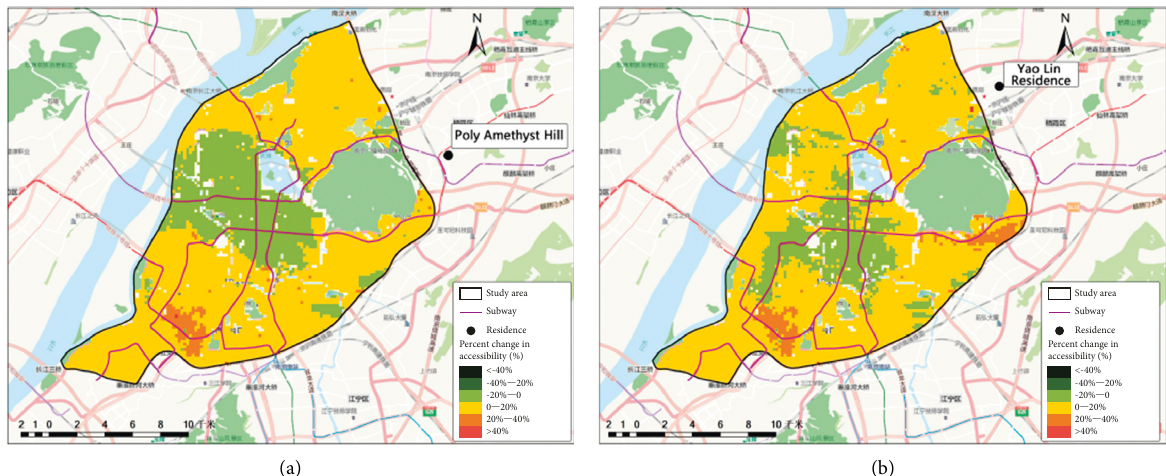
Figure 6: Rangeability in accessibility to Xianlin under the impact of snowstorms. (a) Xianlin, Poly Amethyst Hill, commercial housing complex. (b) Xianlin, Yao Lin Residence, sheltered housing.